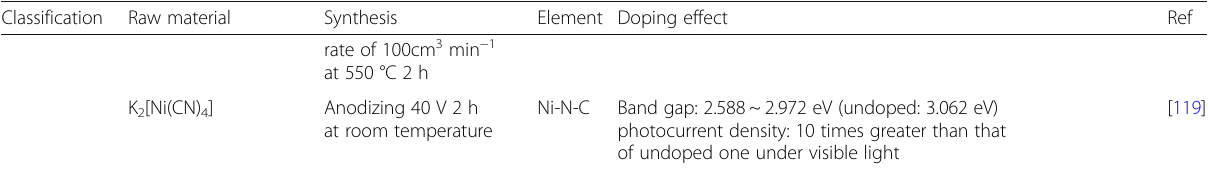
Table 2 Some doped-elements, preparation methods, and the doping effects of doped titania nanotubes as based on the classification of metal-doping, non-metal doping, and co-doping (Continued) Classification Raw material